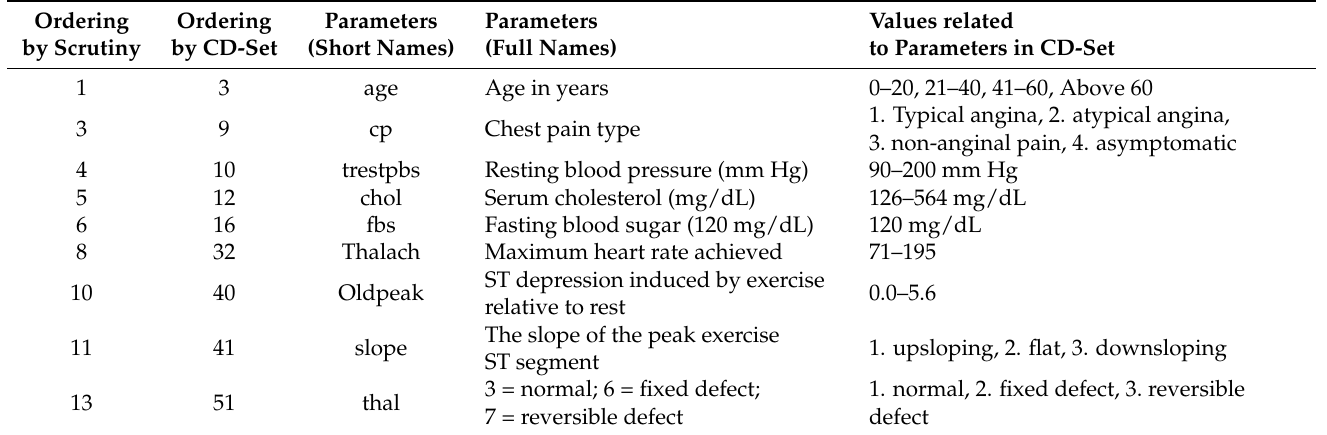
Table 2. Description of subparametric values for opted